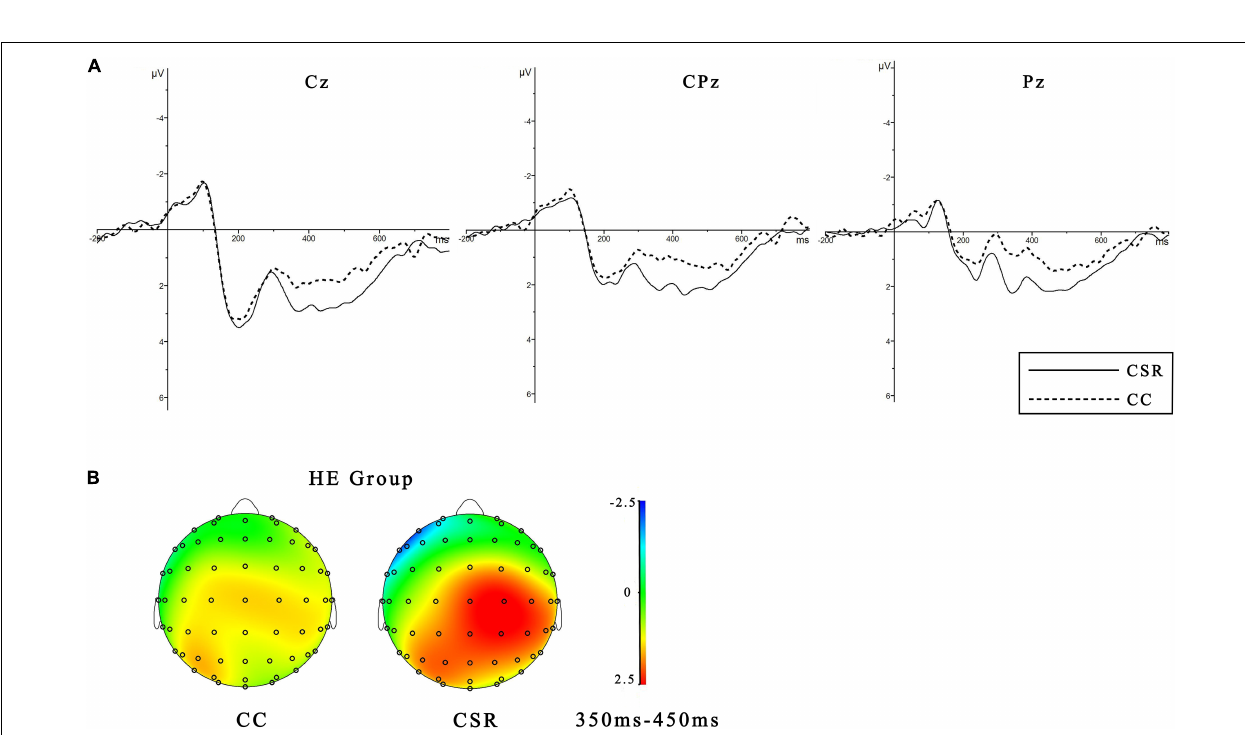
FIGURE 3 | Event-related potentials (ERPs) results. (A) Grand averaged waveforms of N2 for high empathy (HE) and low empathy (LE) groups under the two conditions of CSR and CC associations at midline electrodes (Fz, FCz, and Cz). (B) The topographic maps for different conditions with the window of 260–320 ms.